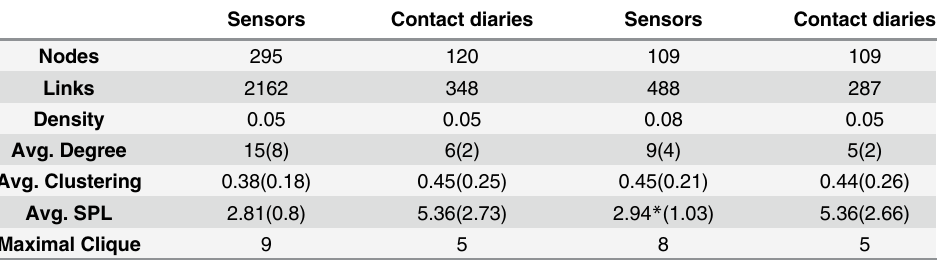
Table 2. Comparison of properties for the contact networks obtained from sensors and diaries. On the day of collection of the contact diaries, only 295 students out of the 327 participating correctly wore their sen- sors. All network properties for the contact diaries network are computed on its symmetrized version. In this summary table we assume that if a contact is reported by at least one of the two nodes, it exists. The right side of the table is performed after matching the two networks. Matching is done by removing the nodes who did not participate to the survey and the ones who did not have contacts recorded by sensors on the 4th day of the study. A * close to the SPL average means that after the match some isolated nodes appeared. In this case, we computed the average on the connected pairs only. Standard deviations are given in